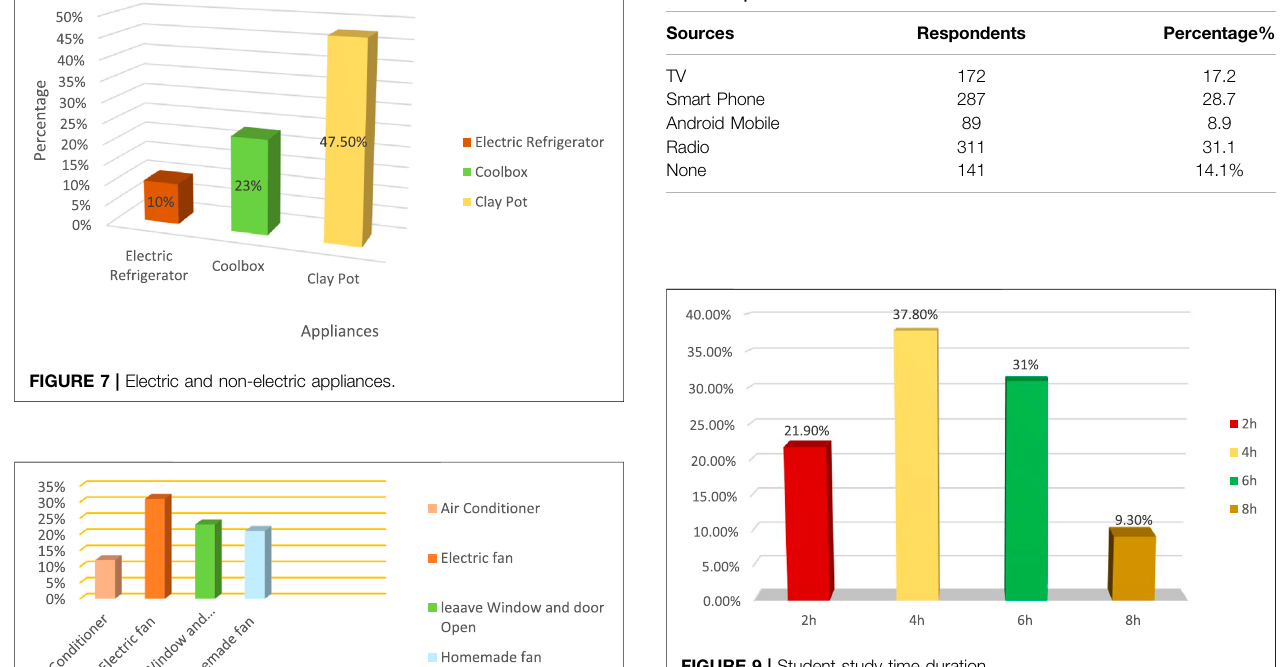
TABLE 9 | Sources of information and communication.